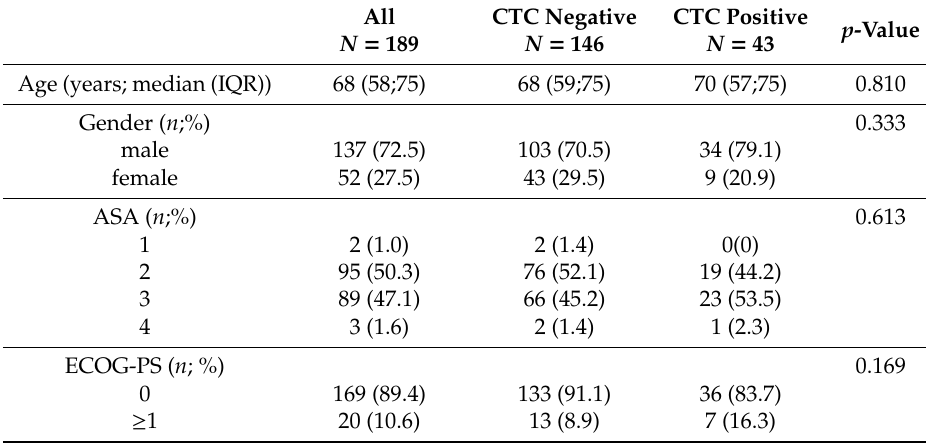
Table 1. Descriptive clinicopathological characteristics of 189 UCB patients who underwent radical cystectomy and bilateral